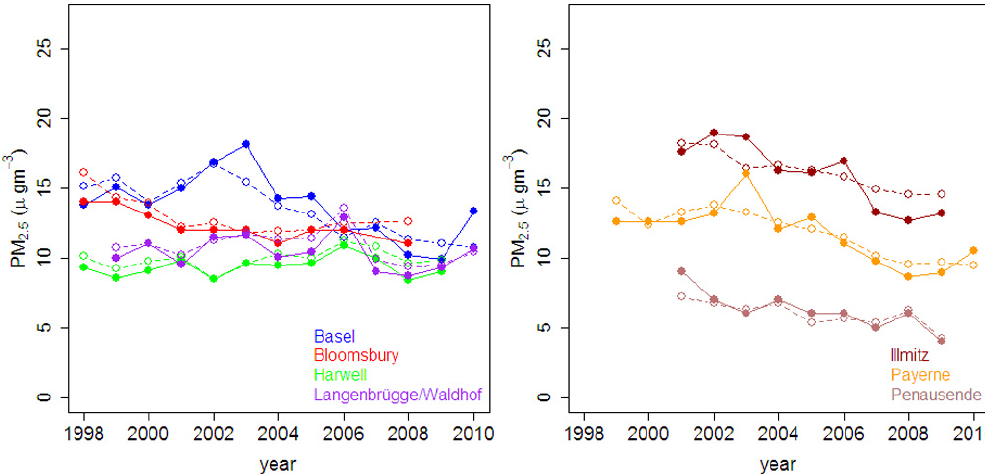
Fig. 6. PM 2 . 5 yearly median time series for all sites. Solid lines indicate raw data and dashed lines indicate meteorologically adjusted data.